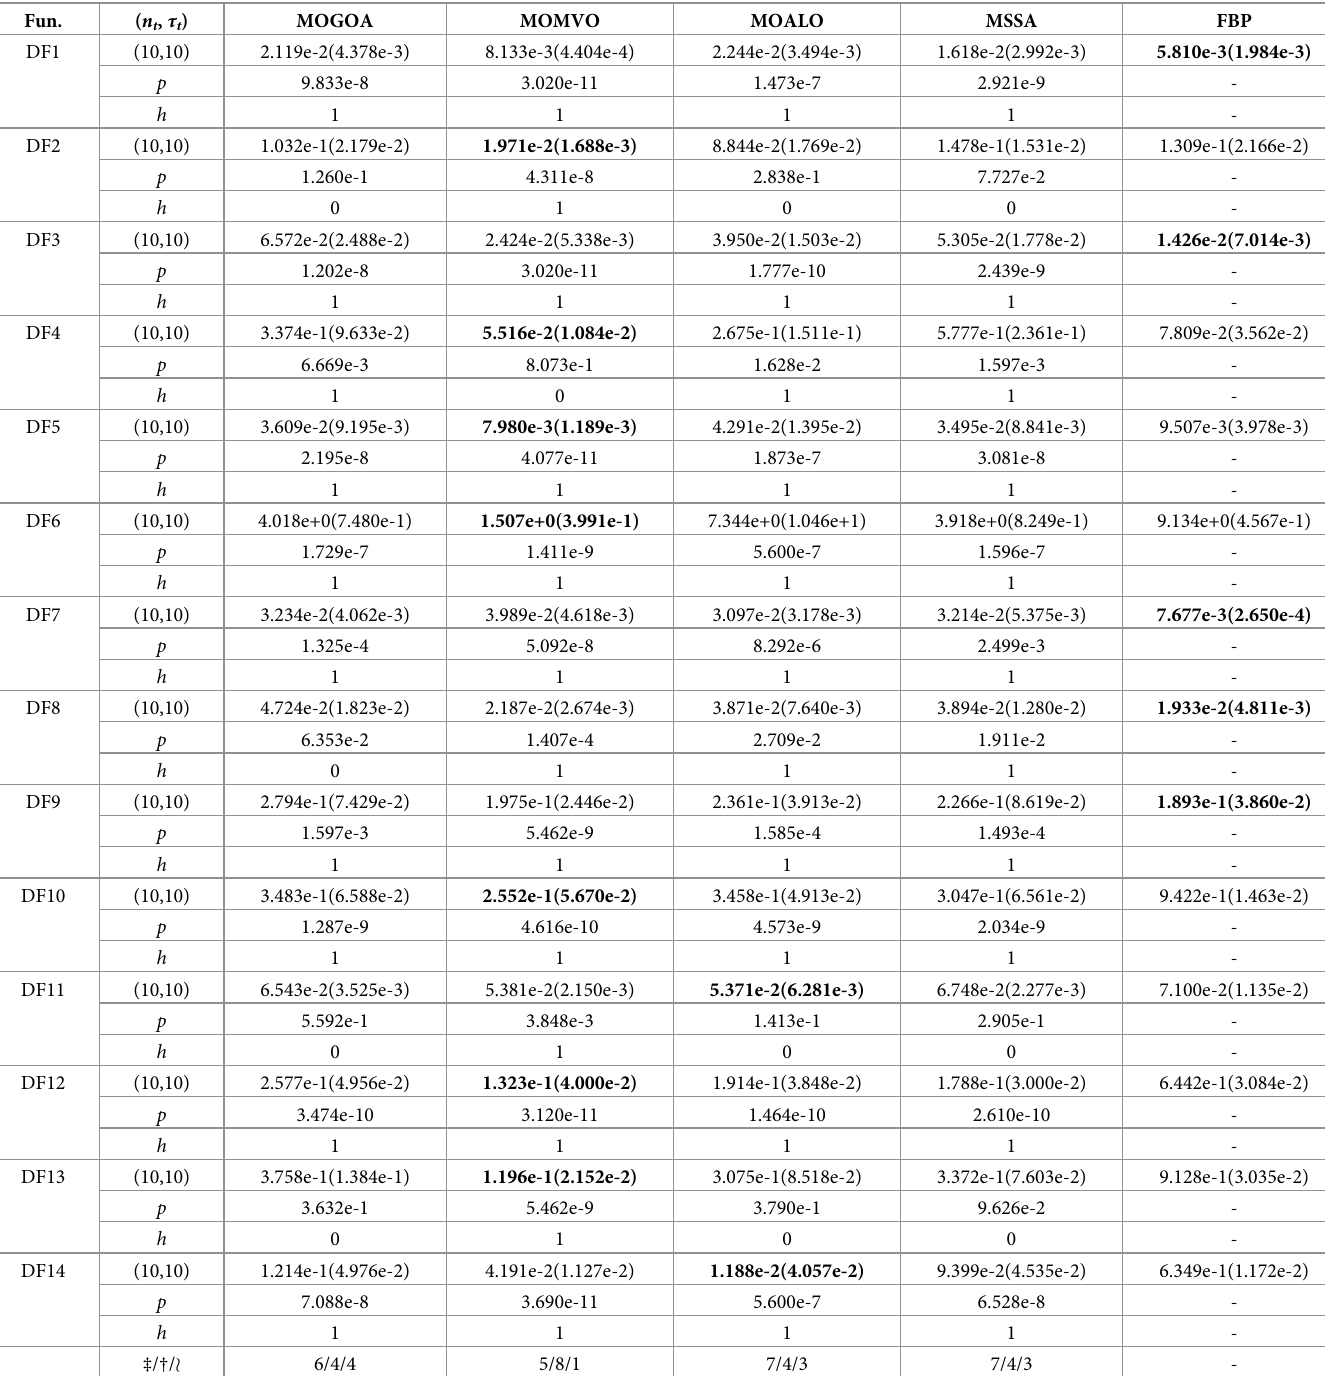
Table 12. Performance comparison of different multiobjective algorithms variants on MSP.